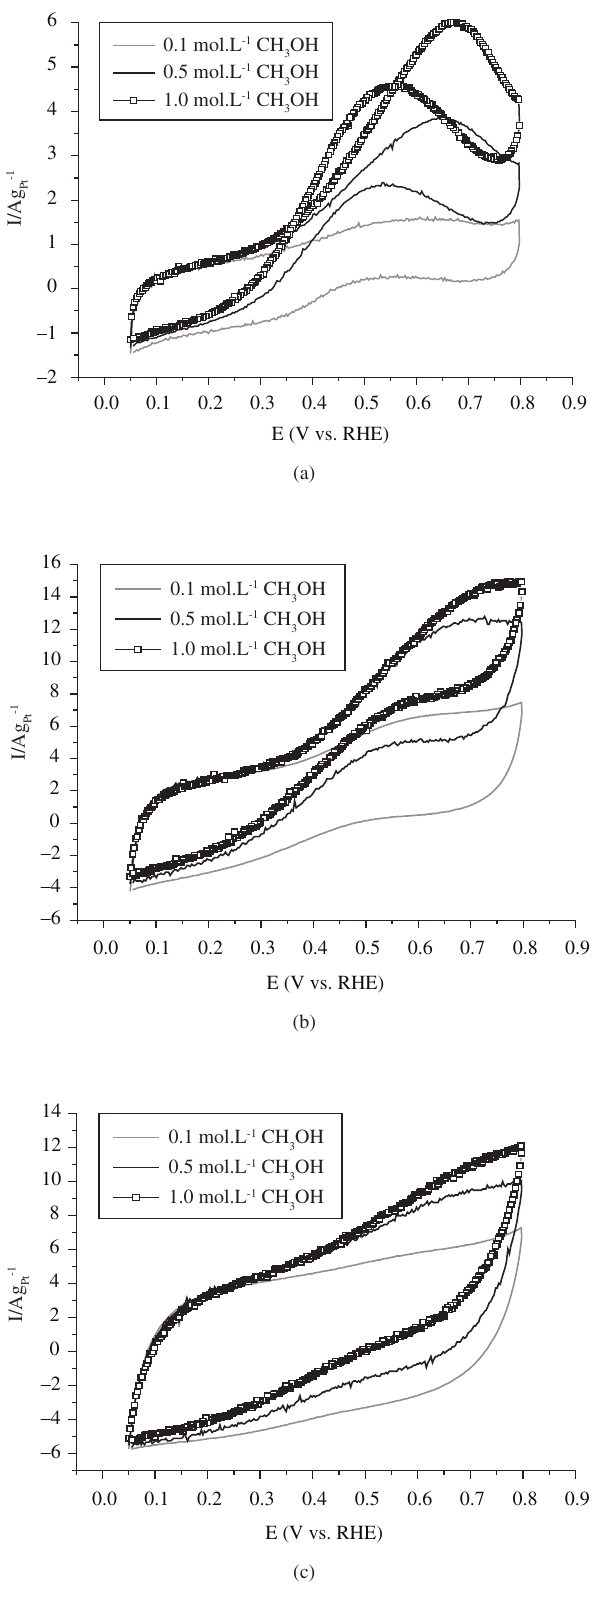
Figure 5. Cyclic voltammograms of PtRu/Carbon materials in 0.5 mol.L -1 H SO and different concentrations of methanol with a sweep rate of 10 mV.s -1 : 2 4 a) glucose 6 hours; b) starch 6 hours; and c) starch 12 hours.